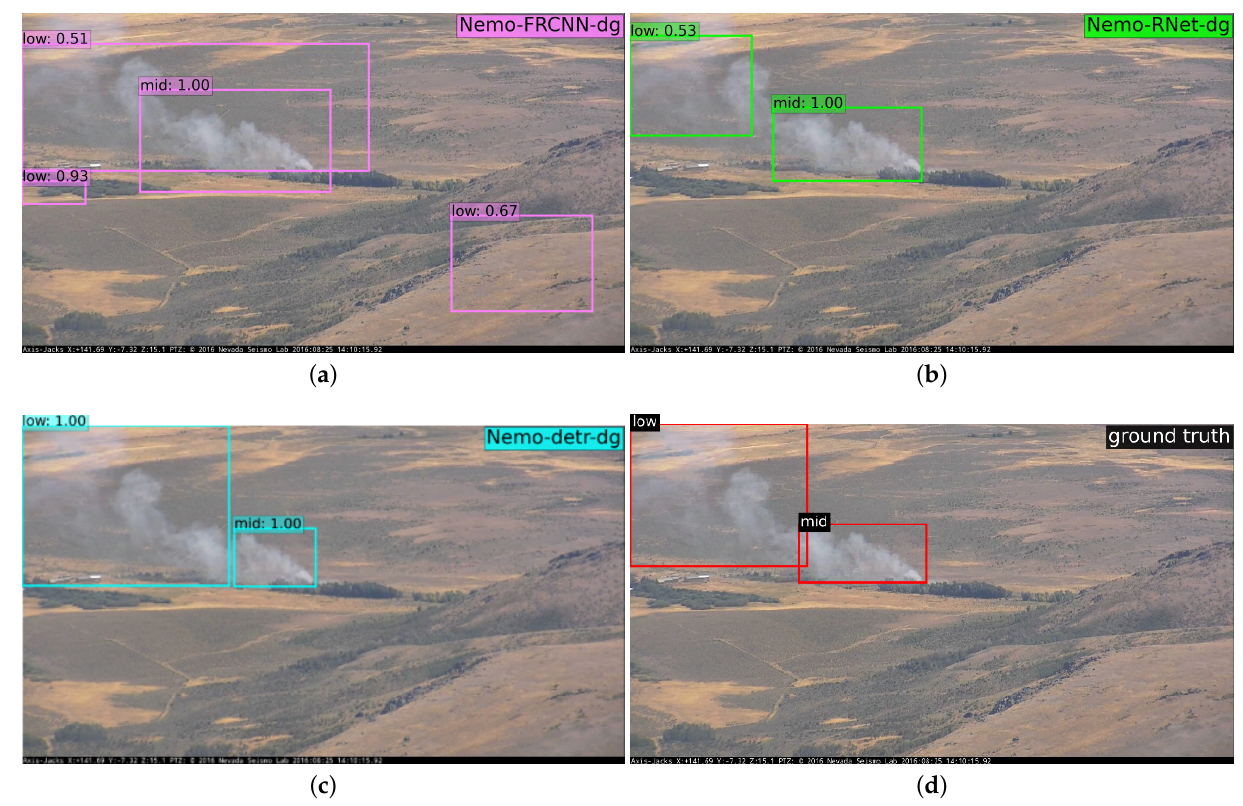
Figure 12. Wildfire smoke density bounding box predictions by ( a ) Faster R-CNN (Nemo-FRCNN- dg), ( b ) RetinaNet (Nemo-RNet-dg), and ( c ) DETR (Nemo-DETR-dg). ( d ) shows the ground truth annotation. The image shown was recorded August 2016 from the Axis-Jacks camera located at Jacks Peak, Northern